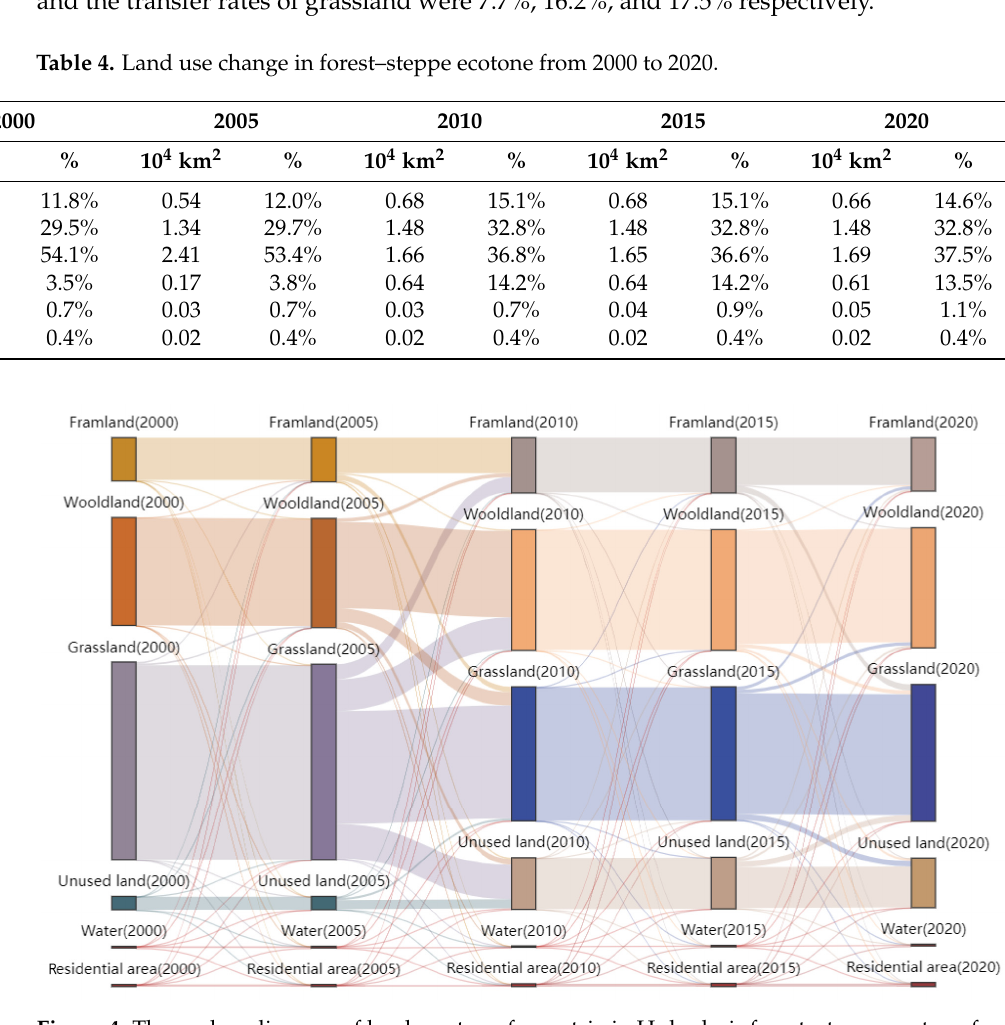
Figure 4. The sankey diagram of land use transfer matrix in Hulunbuir forest–steppe ecotone